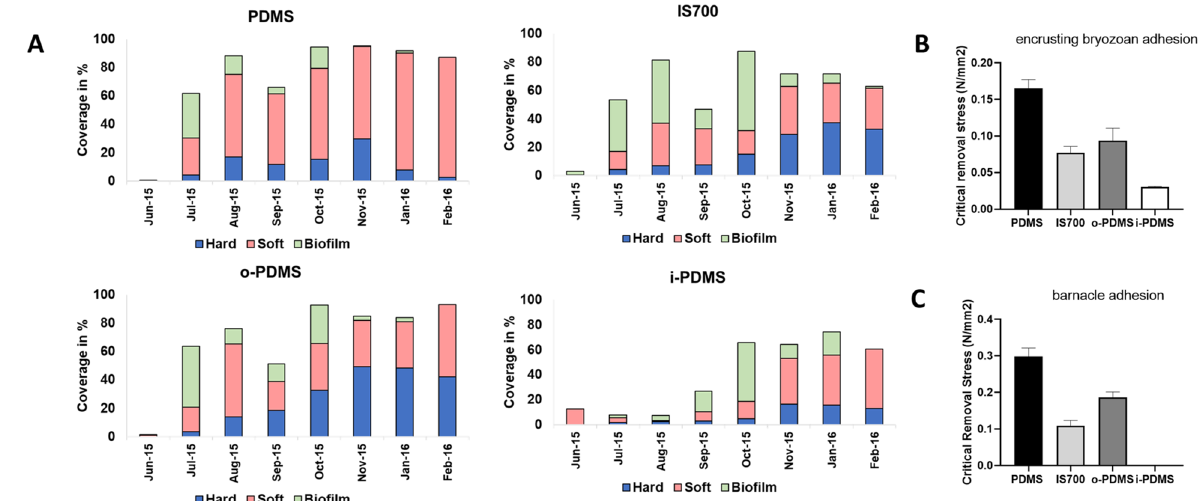
Figure 5. ( A ) Fouling trends on PDMS, IS700, o-PDMS and i-PDMS in Morro Bay over a 15-month immersion period from May 2015 to September 2016. The black line in each dataset corresponds with a pressure washing treatment in March 2016 removing all adhered fouling. Any growth from April 2016 onwards represents a newly established fouling community after pressure-washing the panels. Number of samples (N) = 5. ( B , C ) Encrusting bryozoan ( B ) and barnacle ( C ) adhesion strength to PDMS, IS700, o-PDMS and i-PDMS in Morro Bay. Error bars = standard deviation (SD).